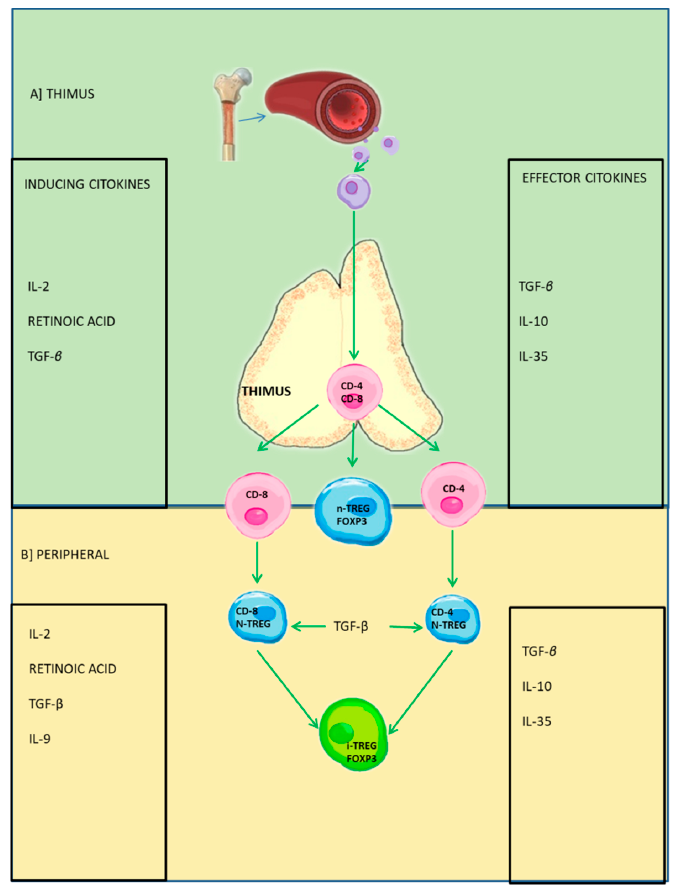
Figure 2. Treg cells: Thymic and peripheral activation. ( A ) Activation of Treg cells in the thymus via inducing cytokines and their effector cytokines. ( B ) Peripheral stimulation that promotes the activation of iTreg cells. The activation of these cells allows for balance in the immune response. 3. T Regulatory Cells, Inflammation, and Peripheral Inflammation Thymic differentiation of Foxp3+ Treg cells requires three main types of signals: (a) ligand-dependent recognition of T-cell antigen receptor (TCR) peptide/MHC-II (pMHC-II); (b) triggered CD28-dependent signaling by costimulatory ligands CD80 or CD86; and (c) cytokine signaling triggered by IL-2 detection. Treg cell differentiation is highly dependent on ligand presentation through three types of antigen-presenting cells (APCs). During maturation in the thymus, thymocytes that exhibit overt reactivity to self-pMHC-II ligands may undergo Treg cell differentiation or clonal deletion [15]. According to the classification of Li (2016) and Savage et al. (2020), there are a series of factors that determine the alternative fates of Treg cells: stochastic, TCR/pMHC-II binding properties, ligand density, type of APC, maturational stage, and age-dependent effects [15,16]. It is not clear whether iTregs and pTregs are similar populations that use the same suppressive mechanisms (Figure 2). Most of the suppressive activity of freshly isolated Foxp3+ T cells is mediated by nTregs. However, little is known about the mechanisms of action of Tregs in vivo [17]. 4. Treg Cells and Inflammation The immune system is finely regulated to attack foreign antigens and tolerate self-antigens. Treg cells are a special subpopulation of immunosuppressive T cells that maintain self-tolerance, inhibit autoimmunity, and act as critical negative regulators of